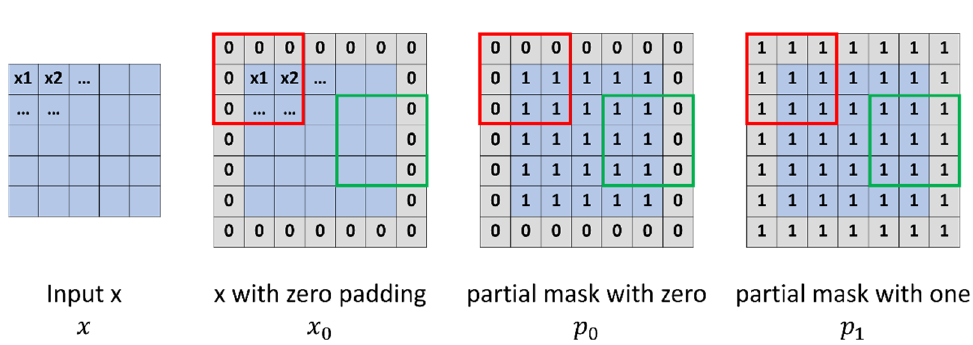
Figure 3. Partial convolution.